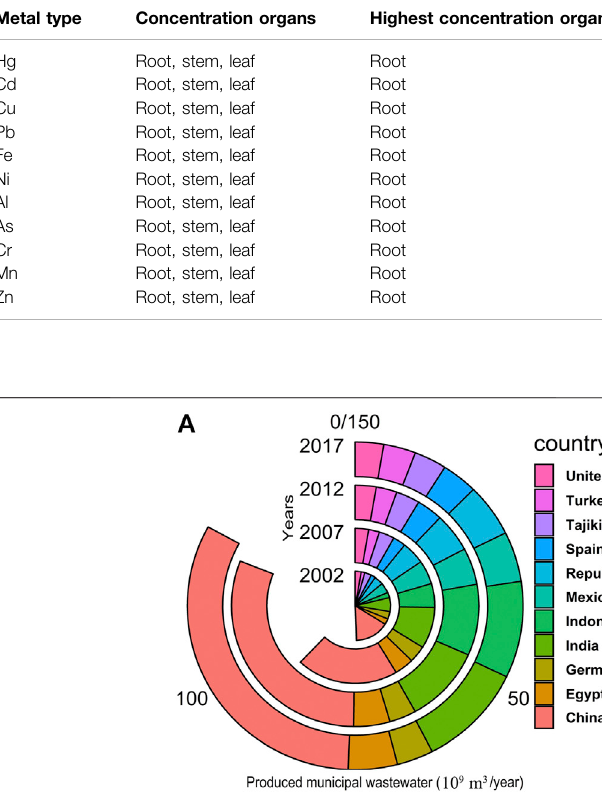
Frontiers in Environmental Science |